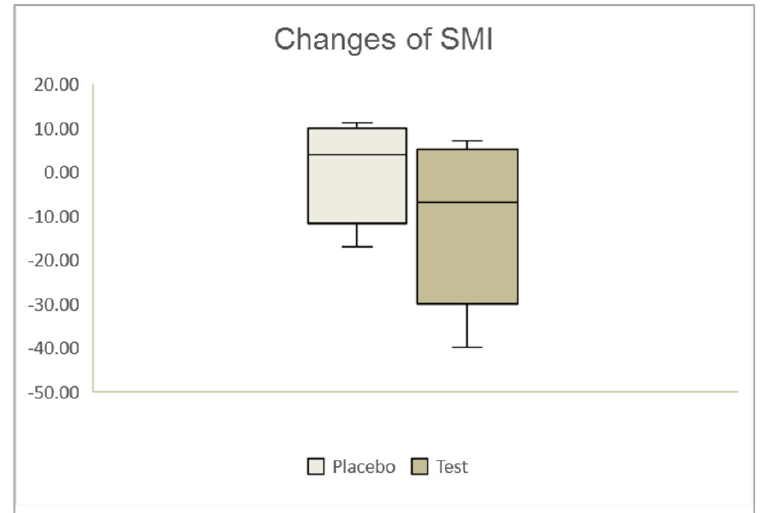
Figure 2. Effect of porcine placenta extract on menopausal symptoms. Comparison of changes of Simplified Menopausal Index (SMI) over 4 weeks between the placebo group and test group.